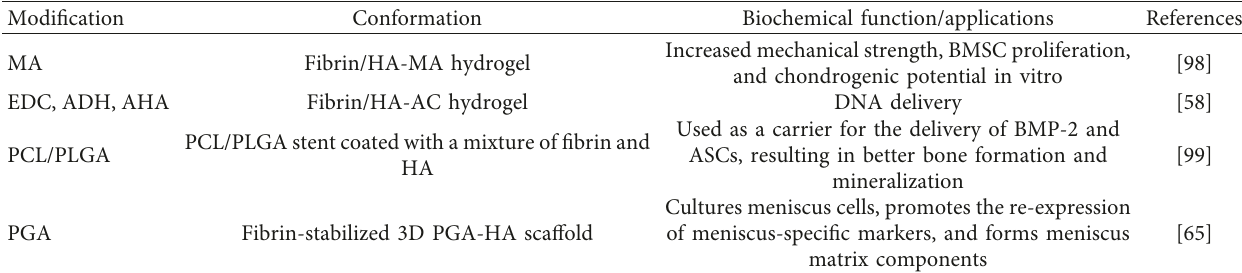
Table 1: Binding to